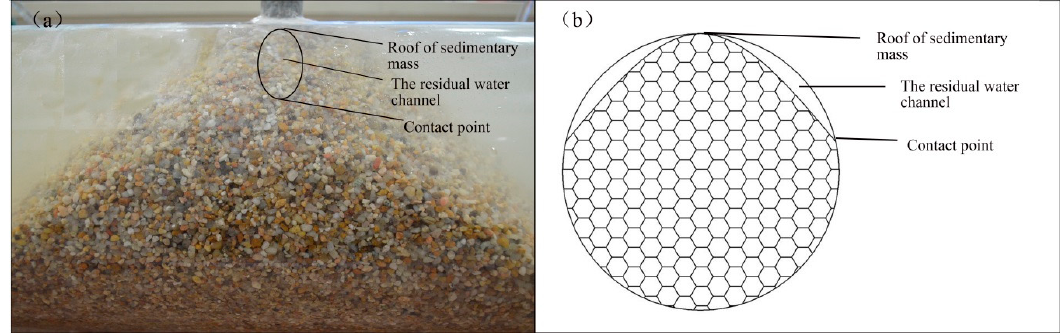
Figure 5. Shape of residual water channel: ( a ) photo; and ( b ) schematic diagram of cross section of deposition under pouring hole.